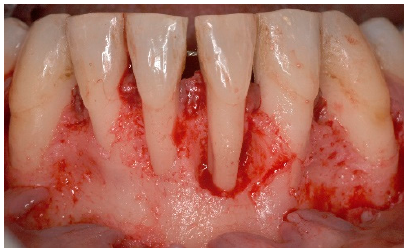
Figure 4. Intra operative aspect, all four lower incisors present extensive root exposure with advanced bone loss, mainly horizontal.